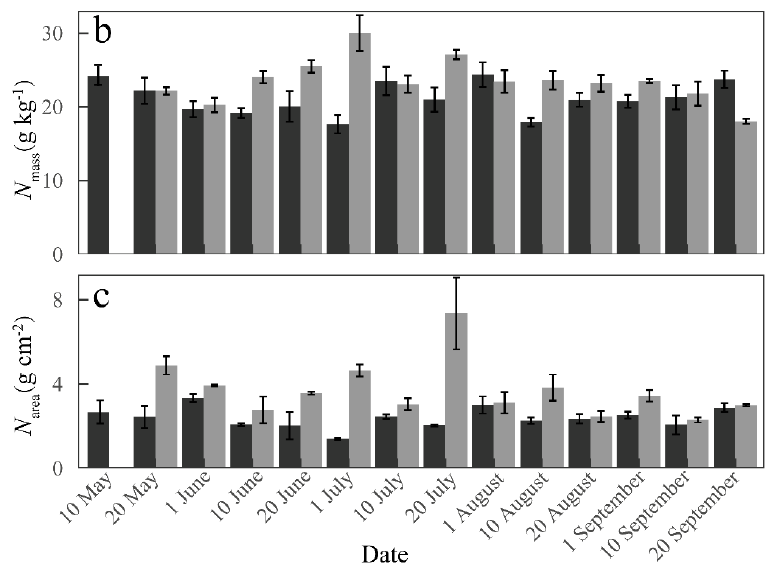
Figure 4. Leaf characteristics, including specific leaf area ( SLA , ( a )), leaf N concentration by dry weigh ( N mass , ( b )), and N concentration per unit leaf area ( N area , ( c )) for A. ordosica and L. secalinus during the five-month field campaign from 1 May − 30 September 2019. Forests 2021 , 12 , 1372